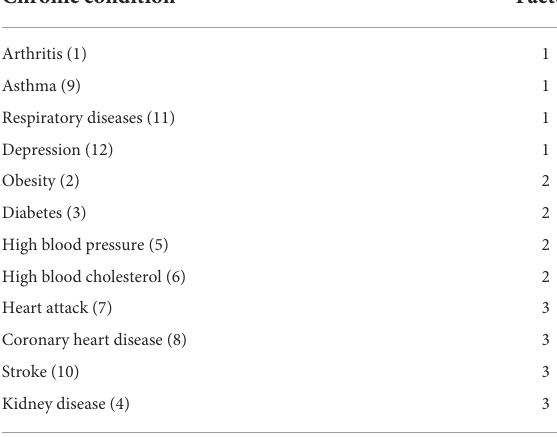
TABLE 2 Grouping of comorbidities according to the EGA.